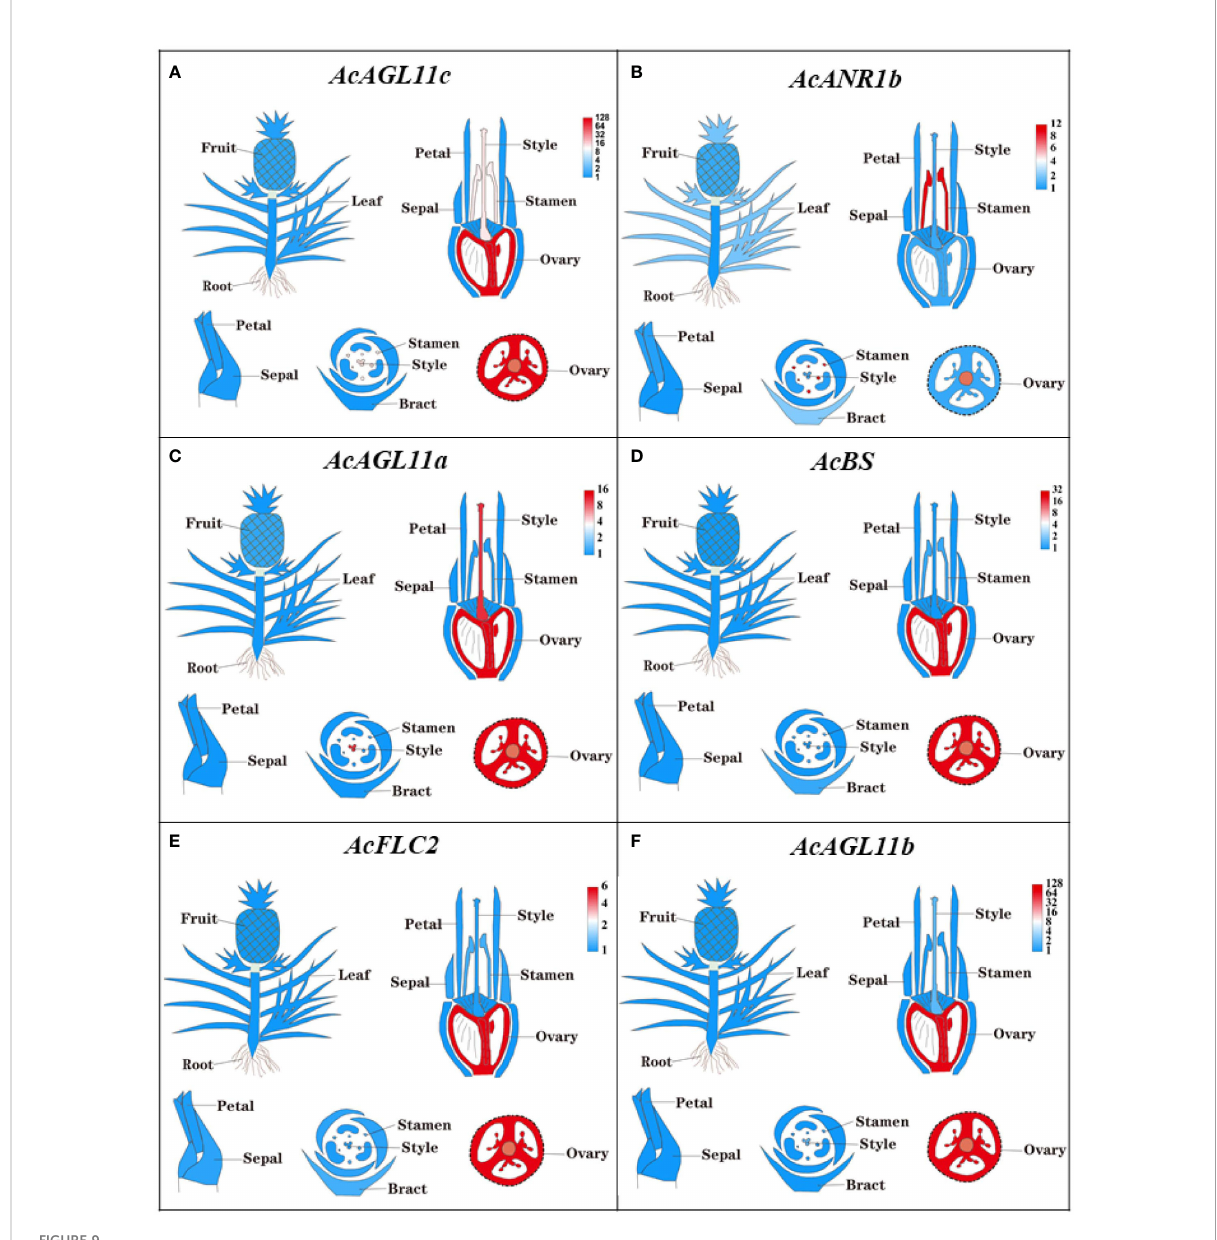
FIGURE 9 The expression of AcMADS genes in different fl oral organs by TBtools. The transcript abundance of AcMADSs were computed by FPKM values and visualized by TBtools. Red module represents tissue high expression and blue module showed low